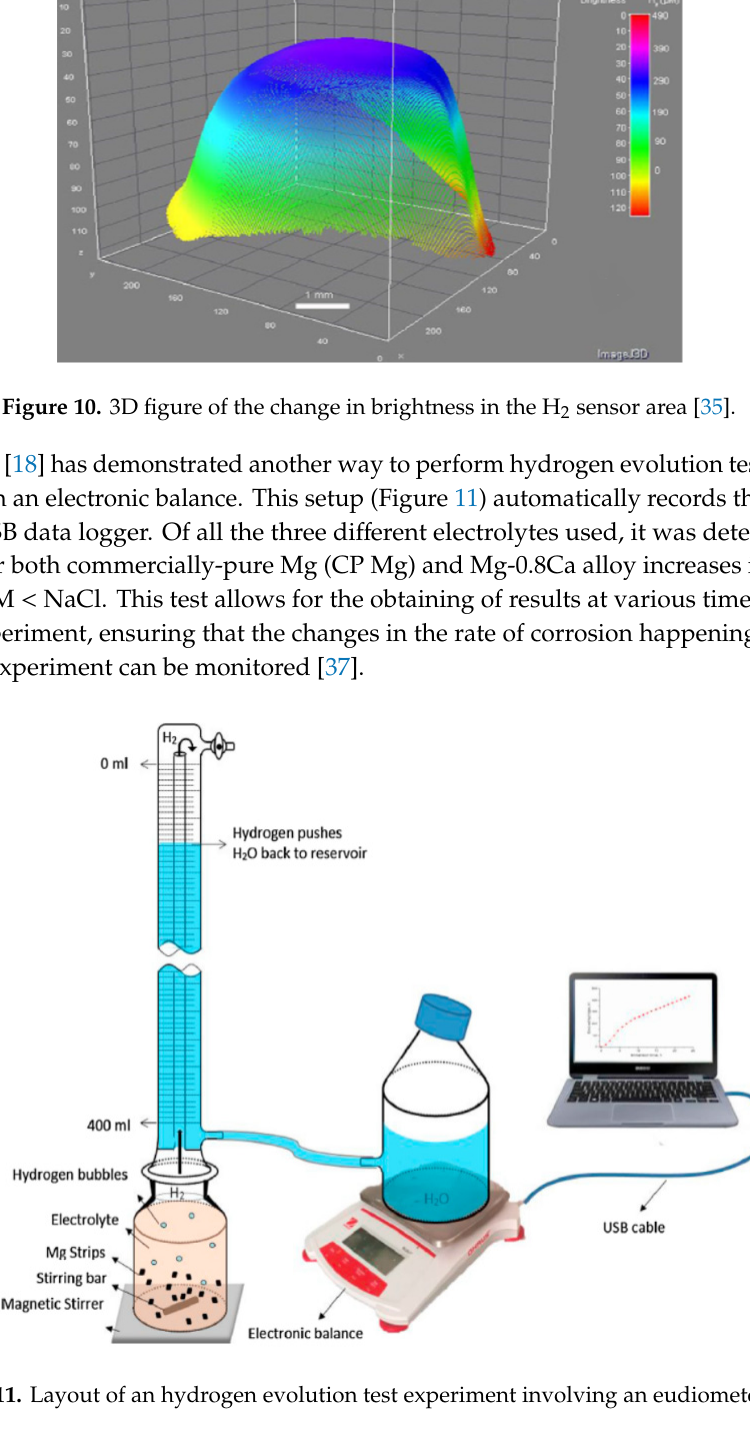
Figure 11. Layout of an hydrogen evolution test experiment involving an eudiometer [18].